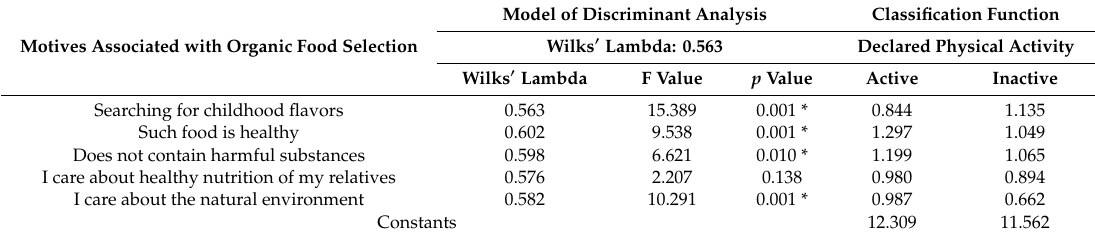
Table1. MotivesfortheselectionoforganicfoodbyPolishresidents, includingdeclaredphysicalactivity. Model of Discriminant Analysis Classification Function Motives Associated with Organic Food Selection Searching for childhood